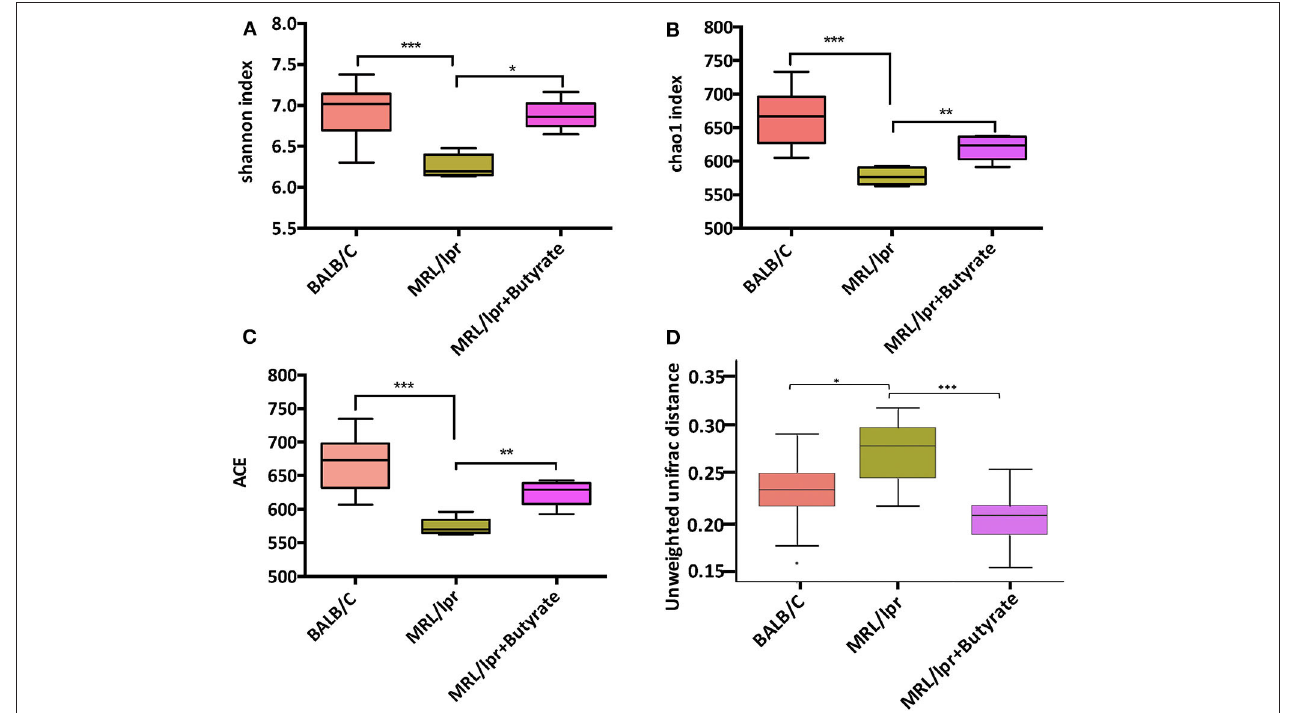
FIGURE 3 | Butyrate treatment elicited an increase in gut microbial diversity. Shannon index (A) , Chao1 index (B) ; ACE index (C) , and unweighted Unifrac distance (D) . Wilcoxon test was utilized to compare two groups; * P < 0.05, ** P < 0.01, *** P < 0.005.